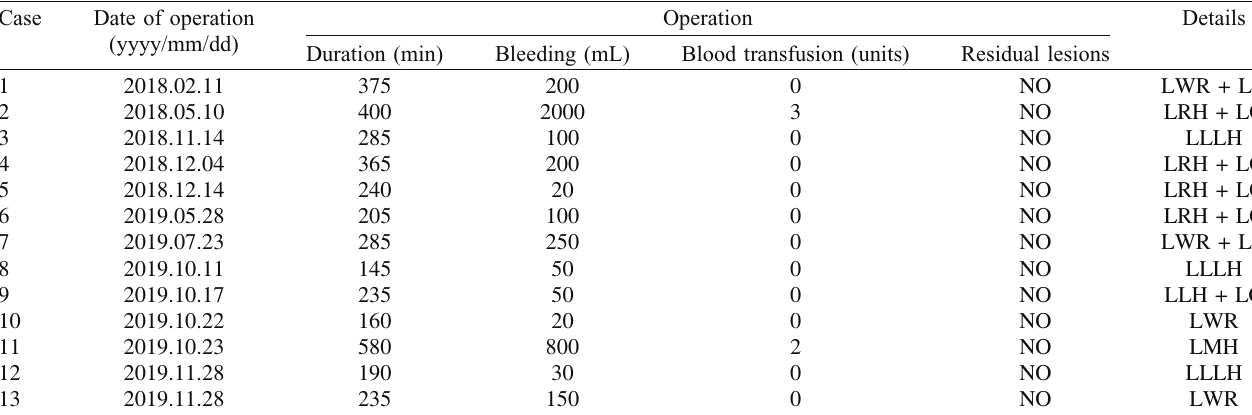
Table 2. Operative parameters for 13 patients.